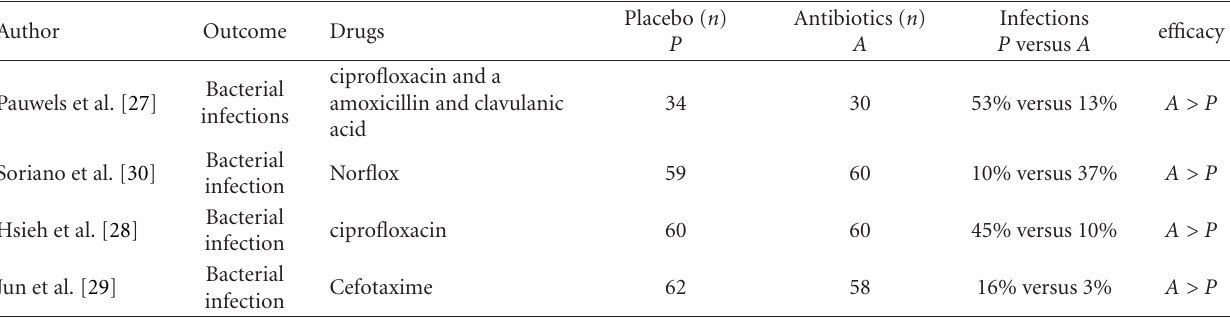
Table 1: Antibiotics compared to placebo in acute variceal bleed.